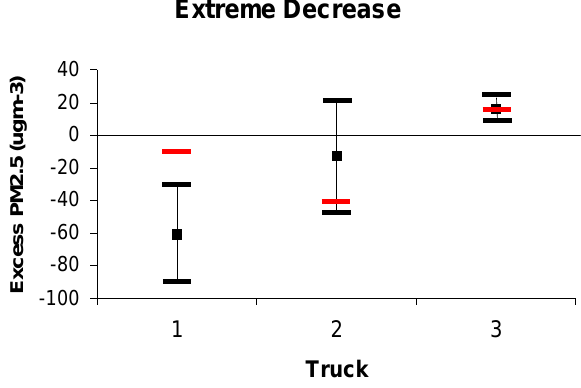
(black squares) at the three Figure 10. Ensemble average Daysmoke minus observed PM 2.5 trucks for the two days of high smoke concentrations at Truck 1 and steep gradients of smoke between the trucks. The spreads of the departures are shown by the horizontal bars. Red bars: Daysmoke minus observed PM for a highly tilted plume for 23 January 2.5